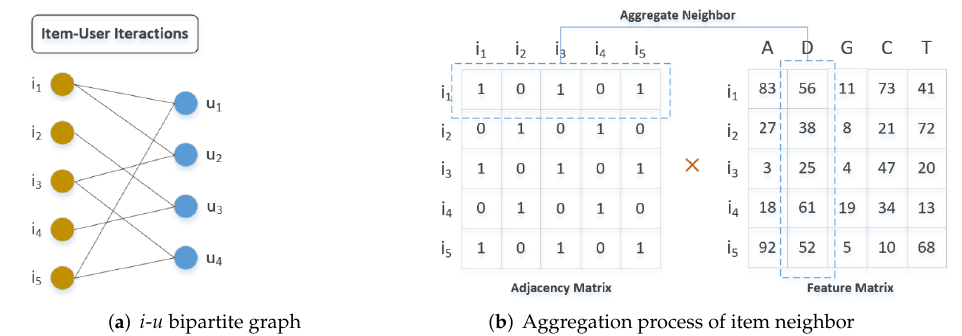
Figure 5. Generating process for an item adjacency matrix and item feature